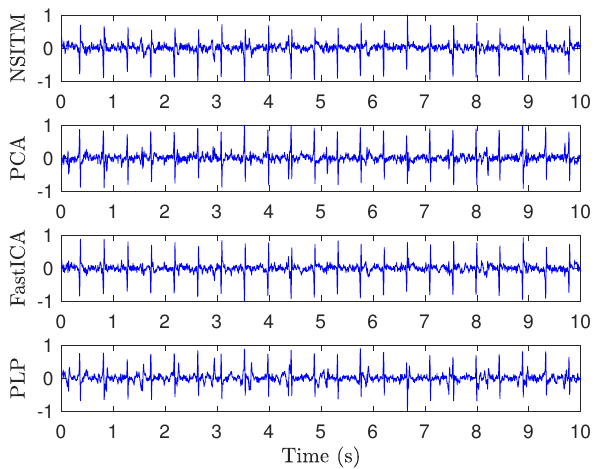
Figure 7. Extracted FECG signals from ECG signals in Figure 6, using NSITM, PCA, FastICA, and PLP, assuming M = 7 (five abdominal signals x 1 ( n ) – x 5 ( n ) and two thorax signals x 6 ( n ) – x 7 ( n ) .The y -axis labels refer to the names of the algorithms used for extracting the FECG signals. Data used are from the DAISY data